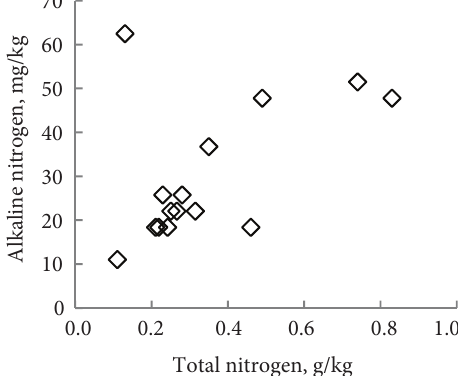
Figure 6. Relationship between total nitrogen and alkaline nitrogen in the aeolian sand